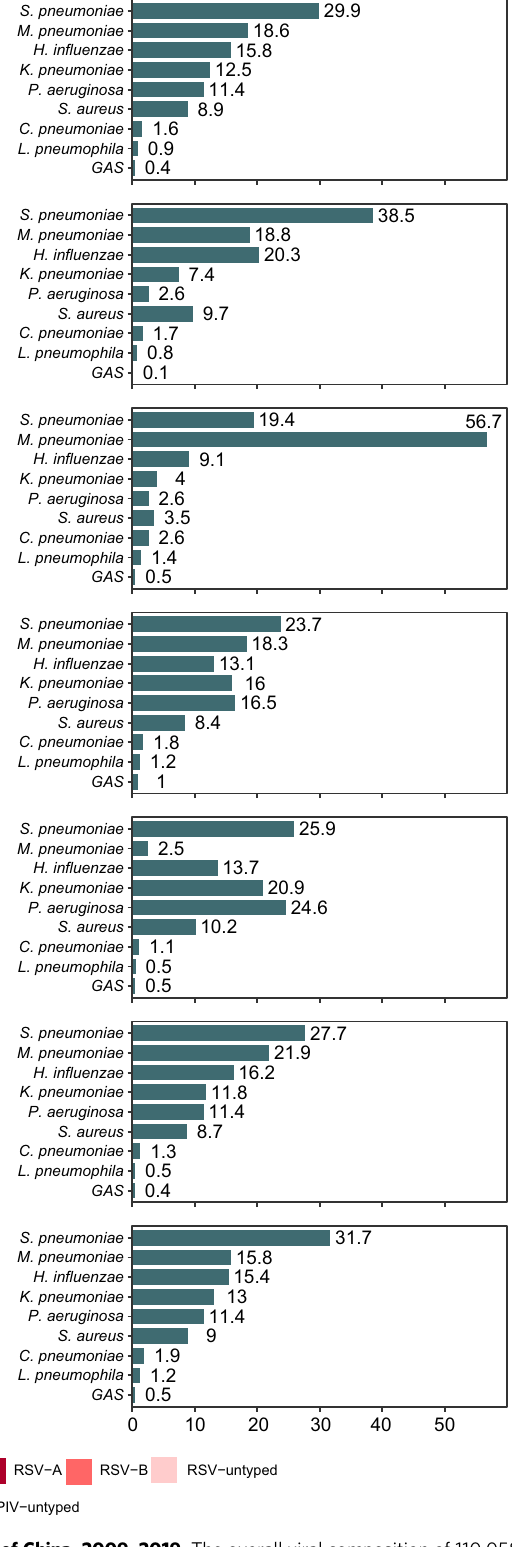
Fig. 2 Viral and bacterial composition of patients with ARIs in the mainland of China, 2009 ‒ 2019. The overall viral composition of 110,058 ARI patients who had all the eight viral pathogens tested. The overall bacterial composition of 26,757 ARI patients who had all the nine bacterial pathogens tested. The length of colored bars and the number behind indicate the proportion of each pathogen, calculated by its positive number used as the numerator and the total positive number of all pathogens used as the denominator. For IFV, RSV, and HPIV, the proportion of their subtypes each colored bar